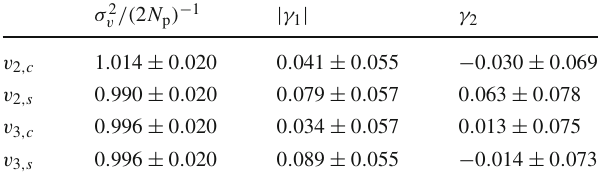
Fig. 5 Probability distribution of v 2 , c / s (top) and v 3 , c / s (bottom) in the initial state of the transport algorithm computed for 5000 events at b = 0 fm Table 1 Moments of the probability distributions displayed in Fig. 5 for the anisotropic flow harmonics in the initial state computed for 5000 events at b = 0 fm. The variance σ 2 v is divided by the estimate 1 / 2 N